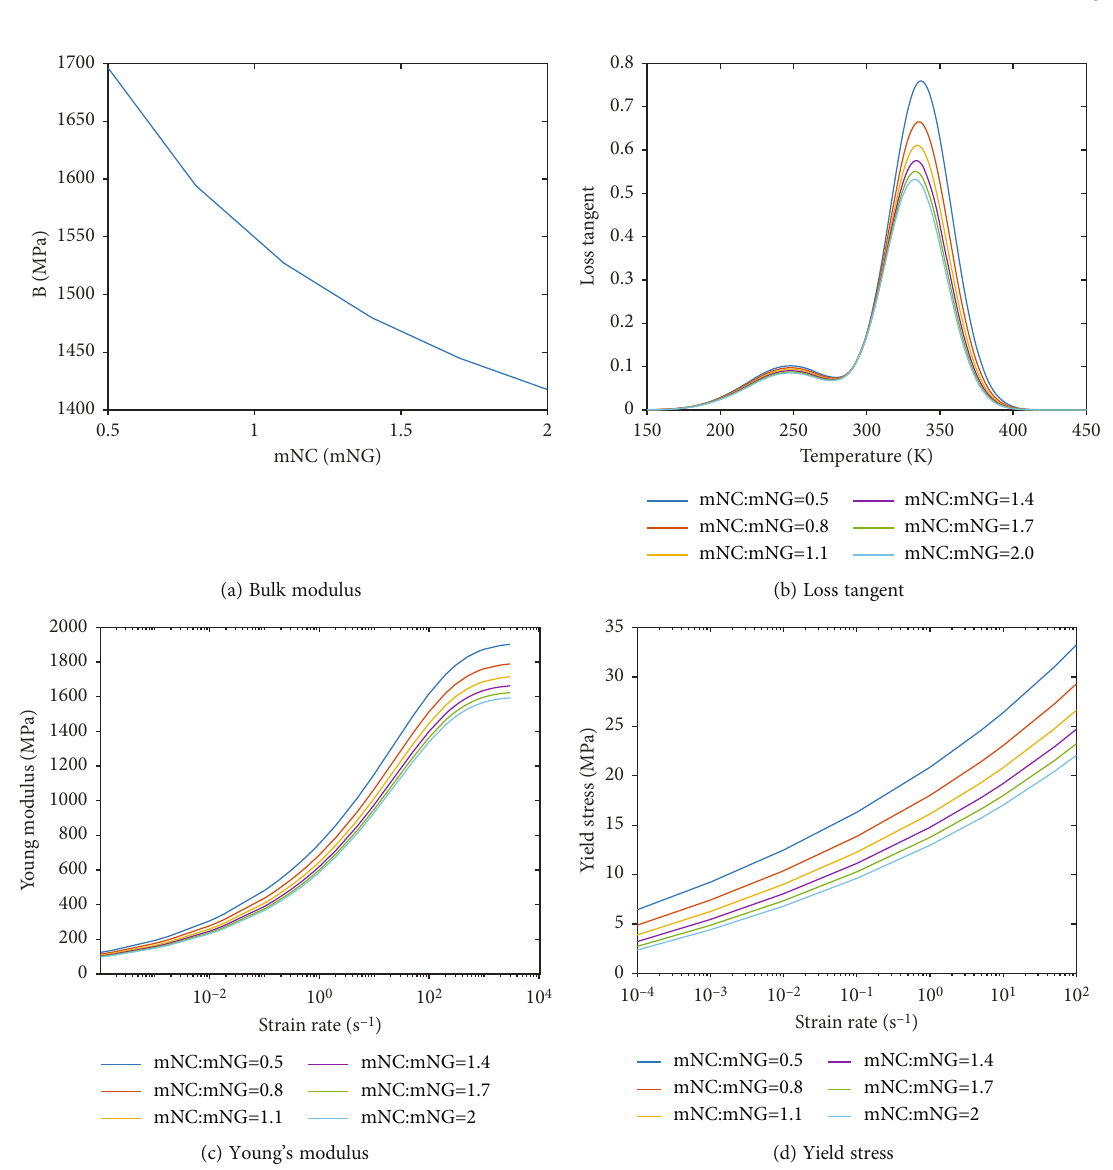
Figure 12: Mechanical properties of the propellant with di ff erent NC/NG mass